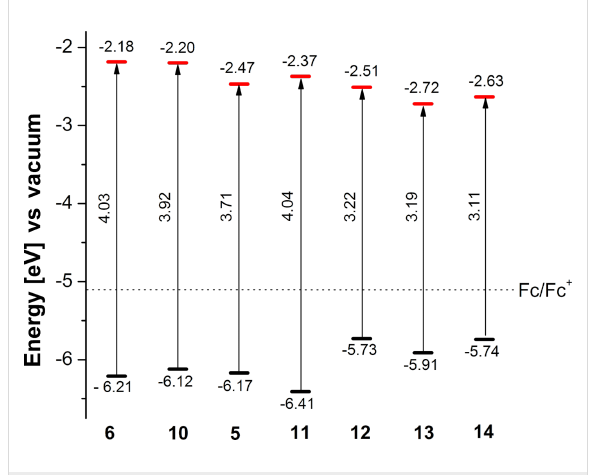
Figure 2: HOMO–LUMO energy level diagram for thiophene–triazole co-oligomers 5 , 6 , 10 – 14 .